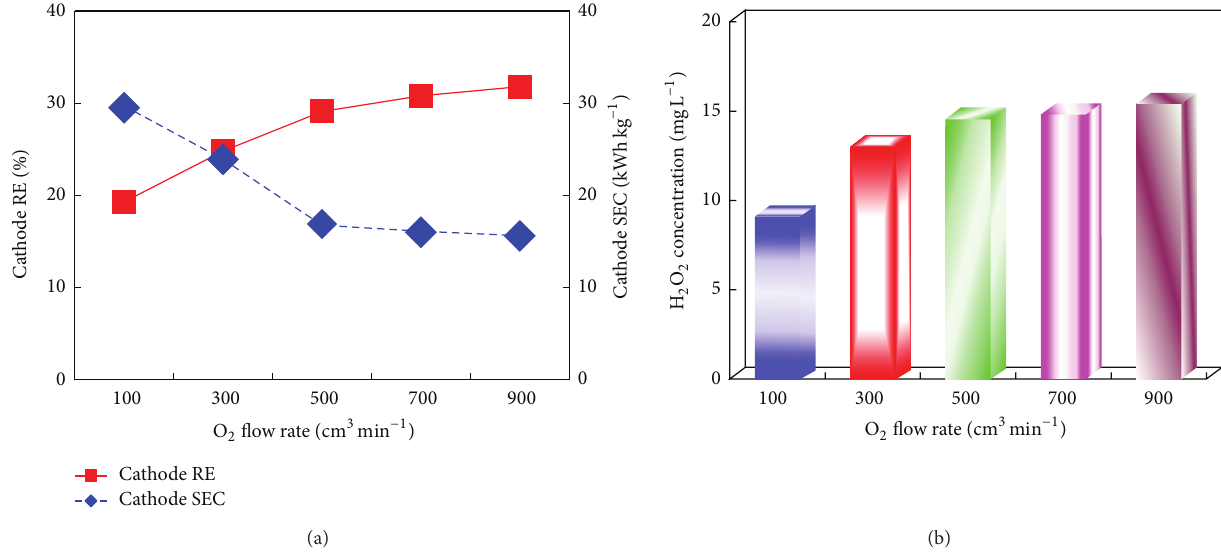
Figure 5: Effect of oxygen flow rate: (a) removal efficiency and SEC of PVA and (b) concentration of H 2 O 2 generation with different oxygen flow rate in the cathodic compartment (current density = 3 mAcm −2 , temperature = 323 K, anodic compartment: PVA = 50 mg L −1 , Ce(III) = 0.01 M, HNO 3 = 0.3 M; cathodic compartment: PVA = 50mg L −1 , Na 2 SO 4 = 0.05 M, pH = 3, and UV-light intensity = 0.4 mWcm −2